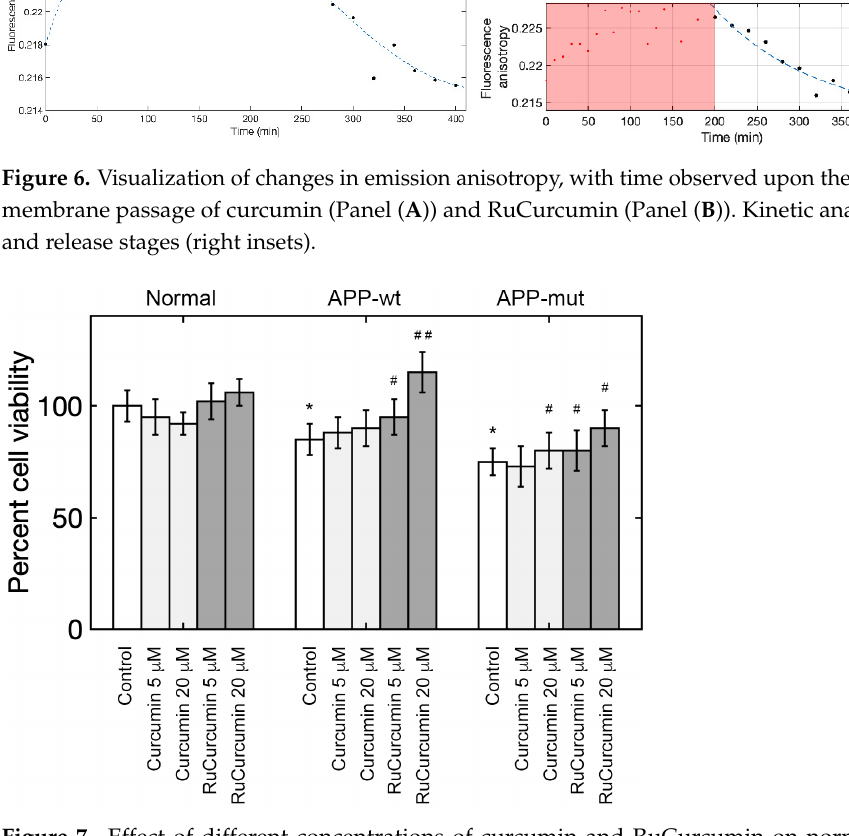
Figure 6. Visualization of changes in emission anisotropy, with time observed upon the SH-SY5Y cell membrane passage of curcumin (Panel ( A )) and RuCurcumin (Panel ( B )). Kinetic analysis of entry and release stages (right insets).